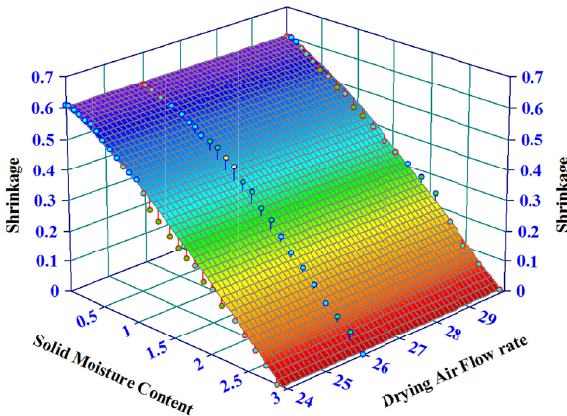
Fig. 9. Variation of hawthorn shrinkage versus solid moisture content at different drying air flow rates (vibration intensity=7.5 Hz and drying air temperature=50 o C)